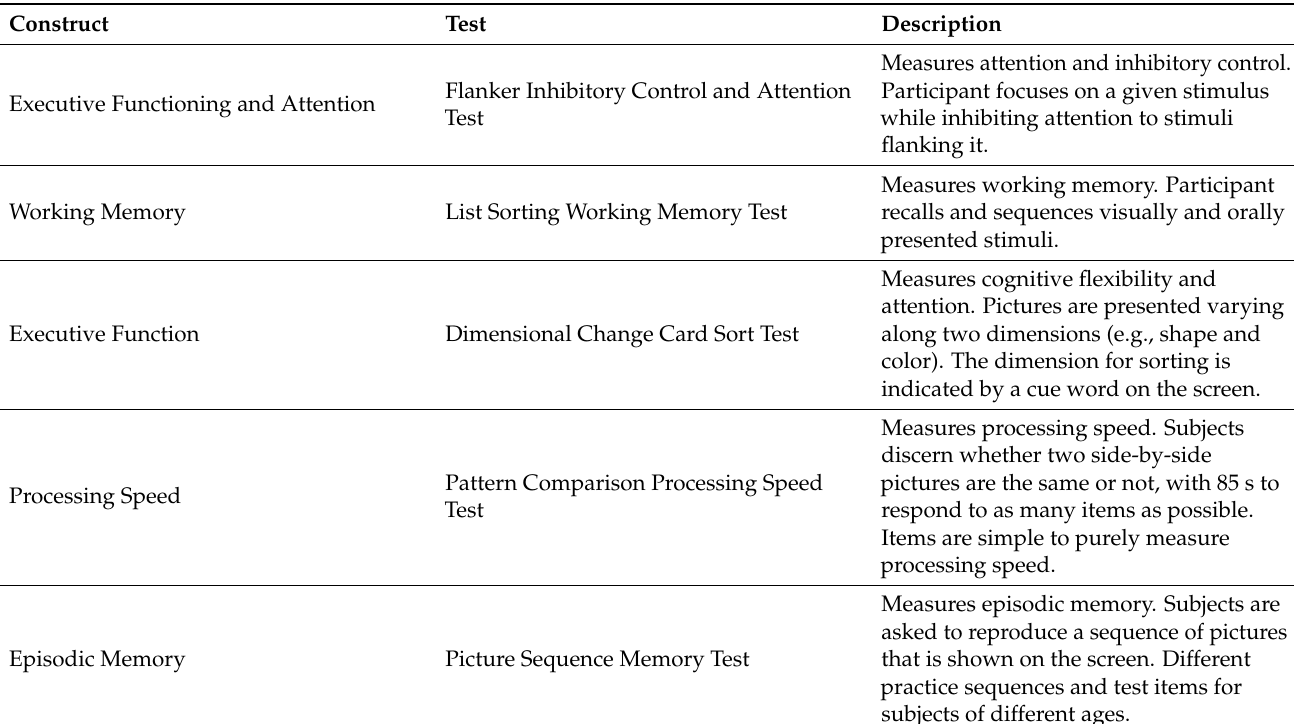
Table 1. NIH Toolbox Cognitive Testing